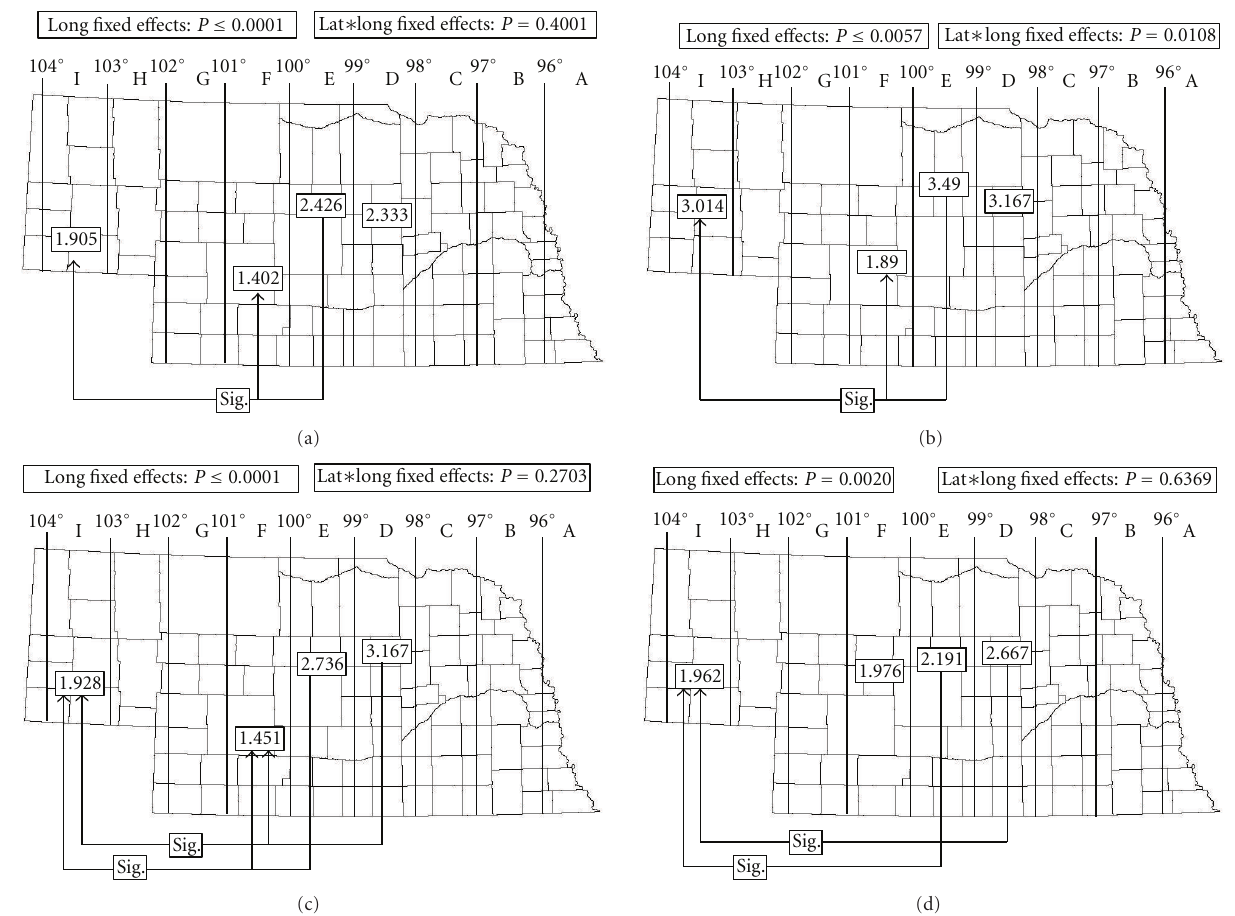
Figure 1: Elytral maculation character states for C. denverensis (adapted from [18]). (a) Total maculation, (b) humeral lunule, (c) middle band, and (d) apical lunule. Significant di ff erences between longitudes shown by arrows and mean value presented in each longitudinal grouping. Fixed e ff ects and e ff ects of latitude by longitude interactions presented at top of each map.